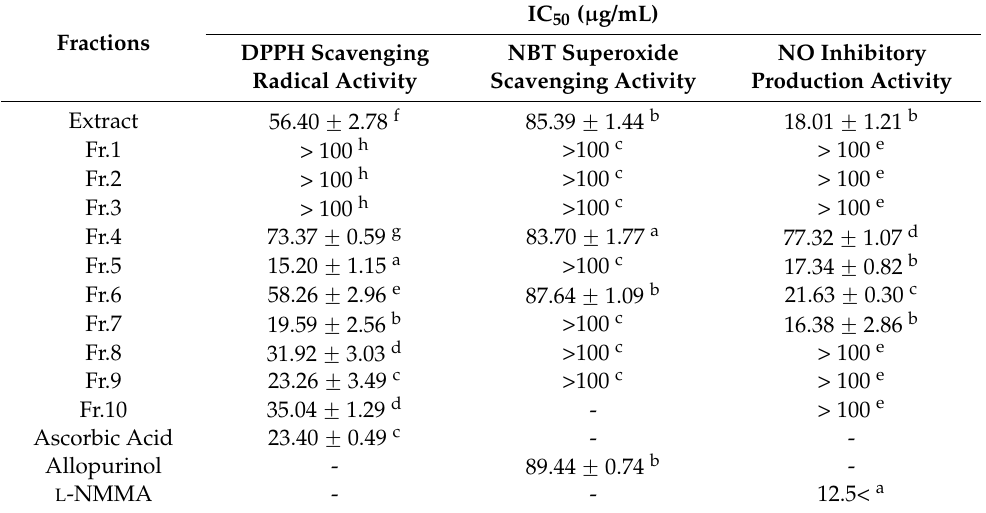
Table 2. IC 50 values of anti-oxidative and anti-inflammatory activities of fractions from